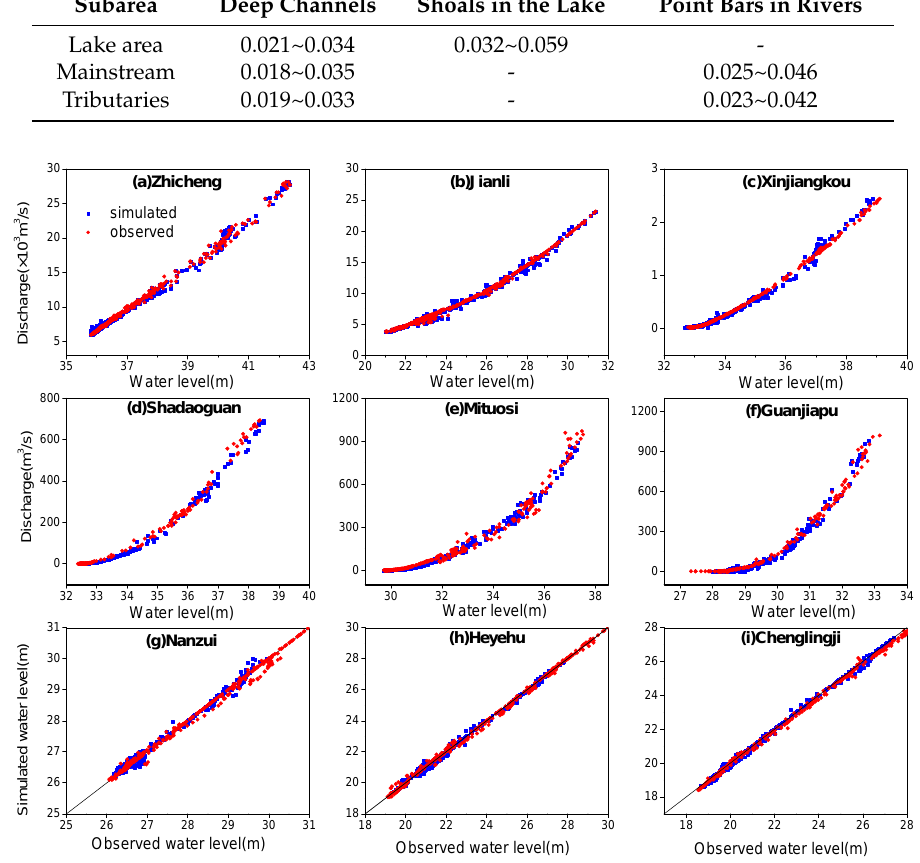
Table 2. Manning roughness coefficients in the coupled model.